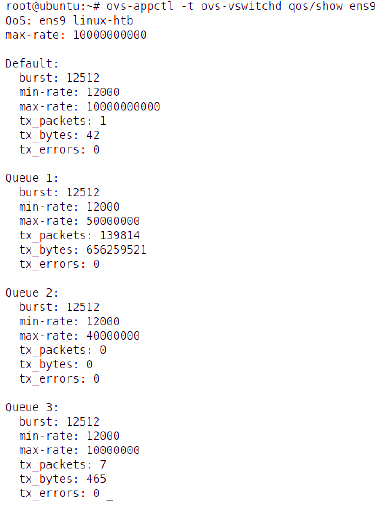
Figure 8. Base station flow table in Scenario 2.